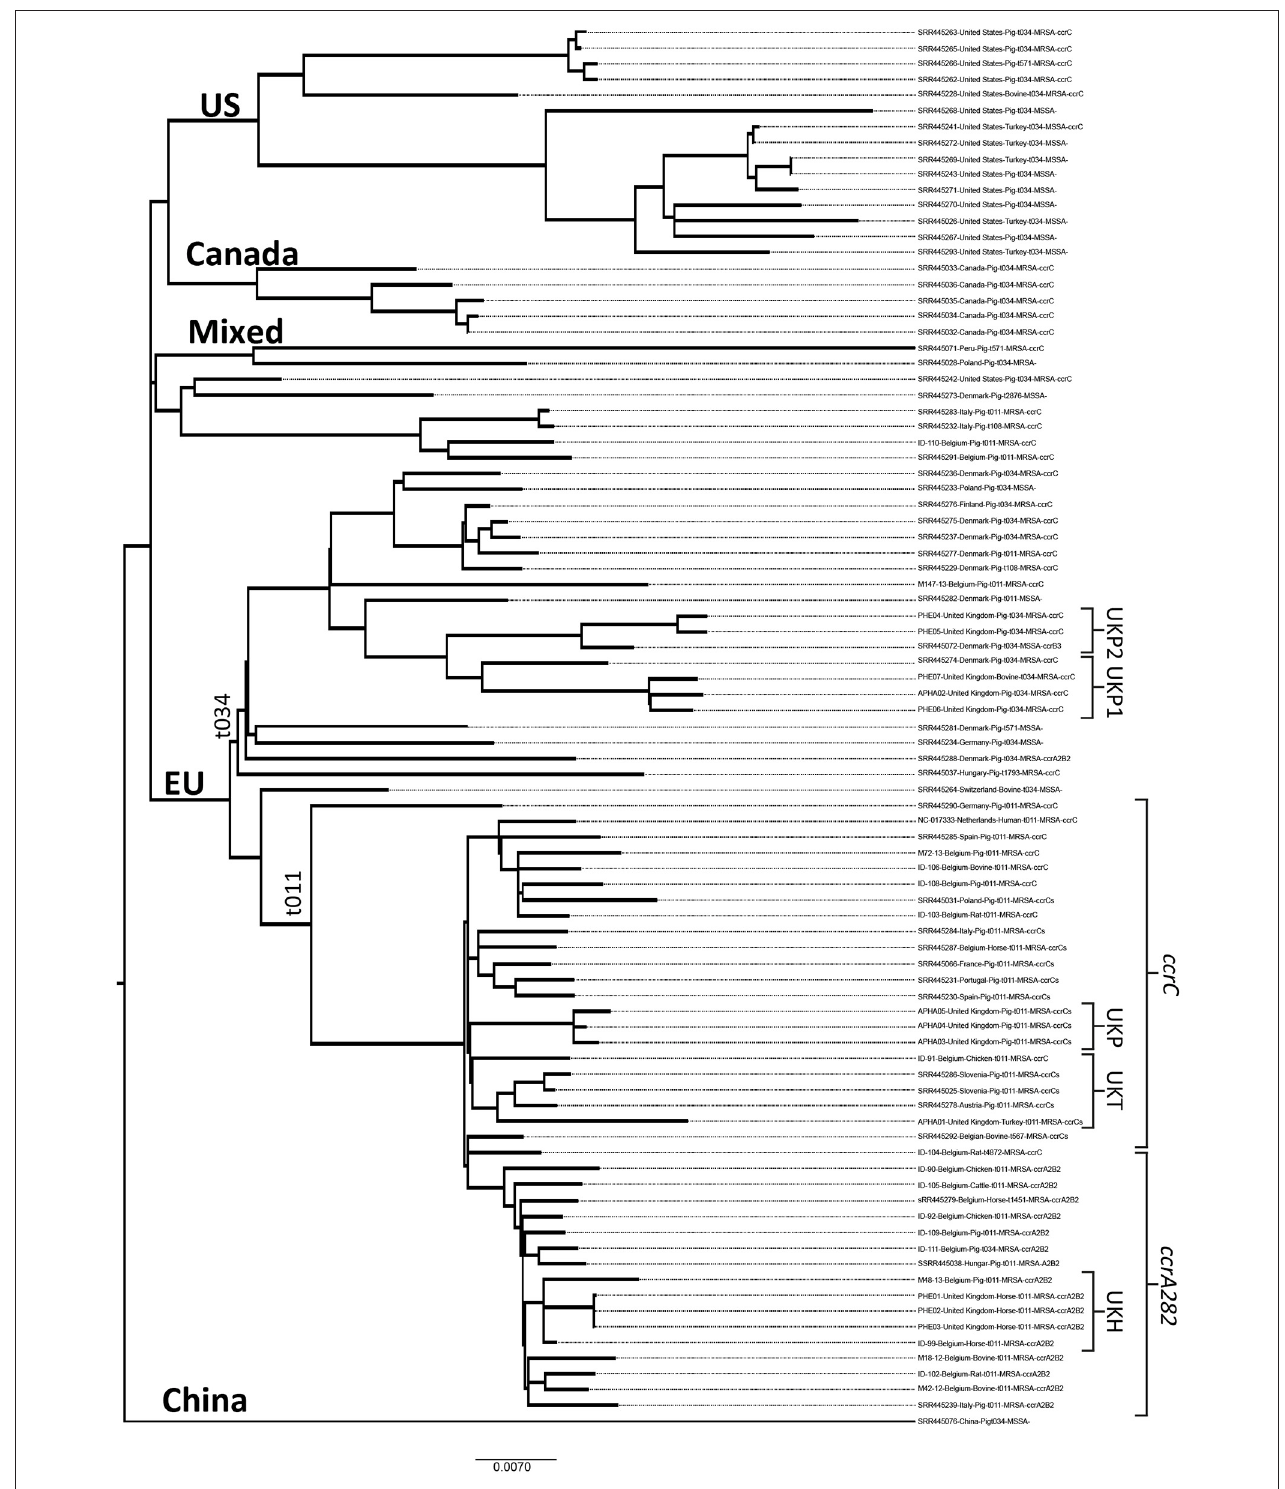
FIGURE 1 | A maximum-likelihood phylogenetic tree of LA-MRSA CC398 animal isolates calculated in RaxML. The largely European and non-European lineages, as well as the dominant spa- types and ccr -types are shown. The following information is also given for each isolate: name/reference, country of origin, host animal, MRSA/MSSA, spa- type, and ccr